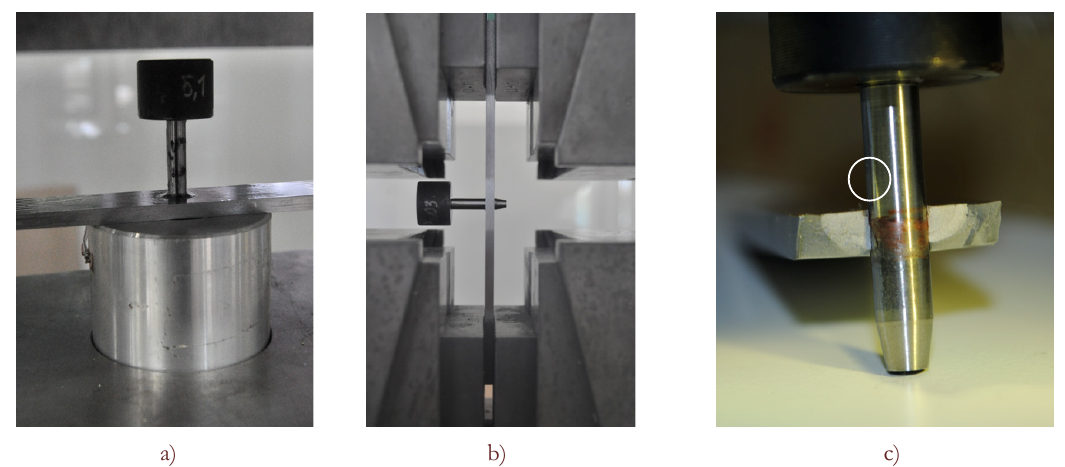
Figure 3: Pin insertion, specimen lock system and fracture surface .